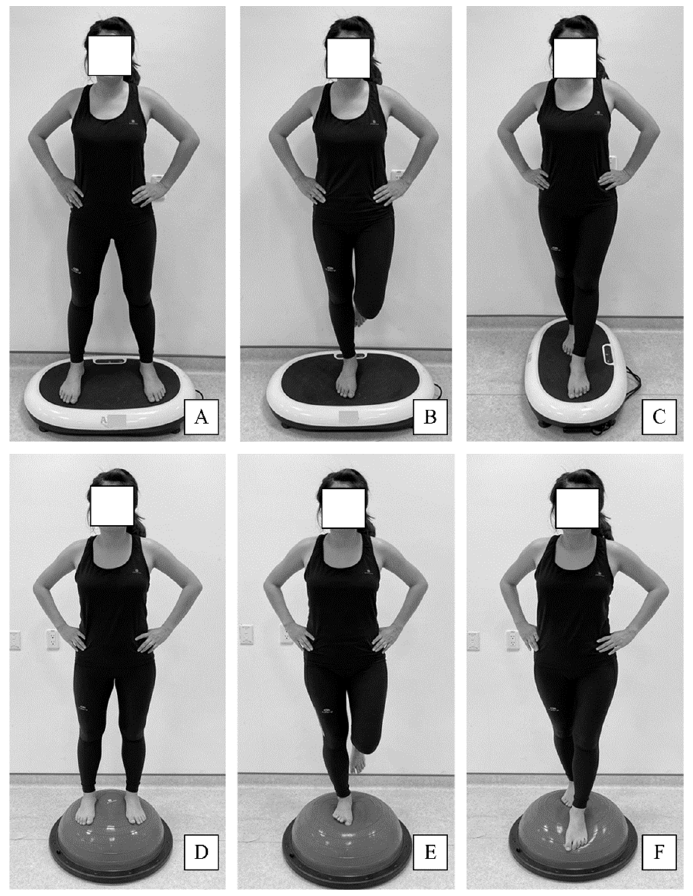
Figure 2. Demonstration of exercises on the vibration platform ( A – C ) and balance ball ( D – F